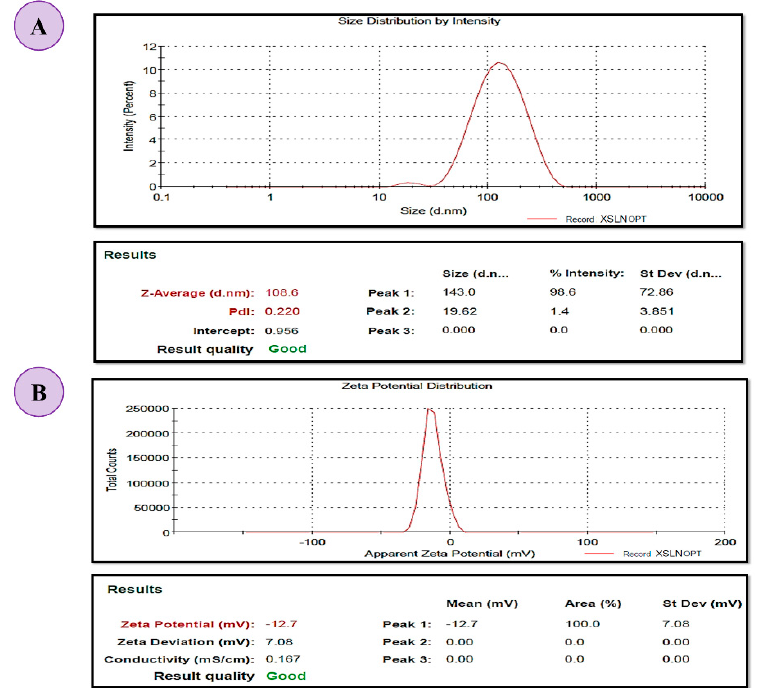
Figure 5. Representing ( A ) PS and PDI, and ( B ) ZP of the optimized